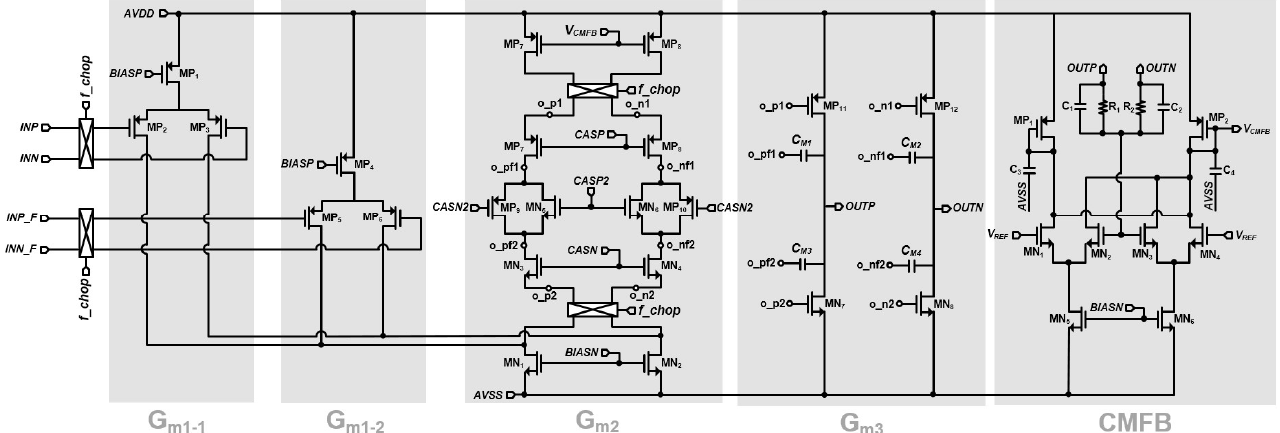
Figure 10. Schematic of the proposed potentiostat readout circuit.